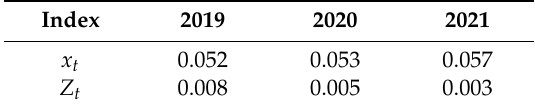
Table 3. Predictions of T HH ( x t ) and the intervention impact ( Z t ) from 2019 to 2021 in the Xin’an River watershed ecological compensation (WEC).